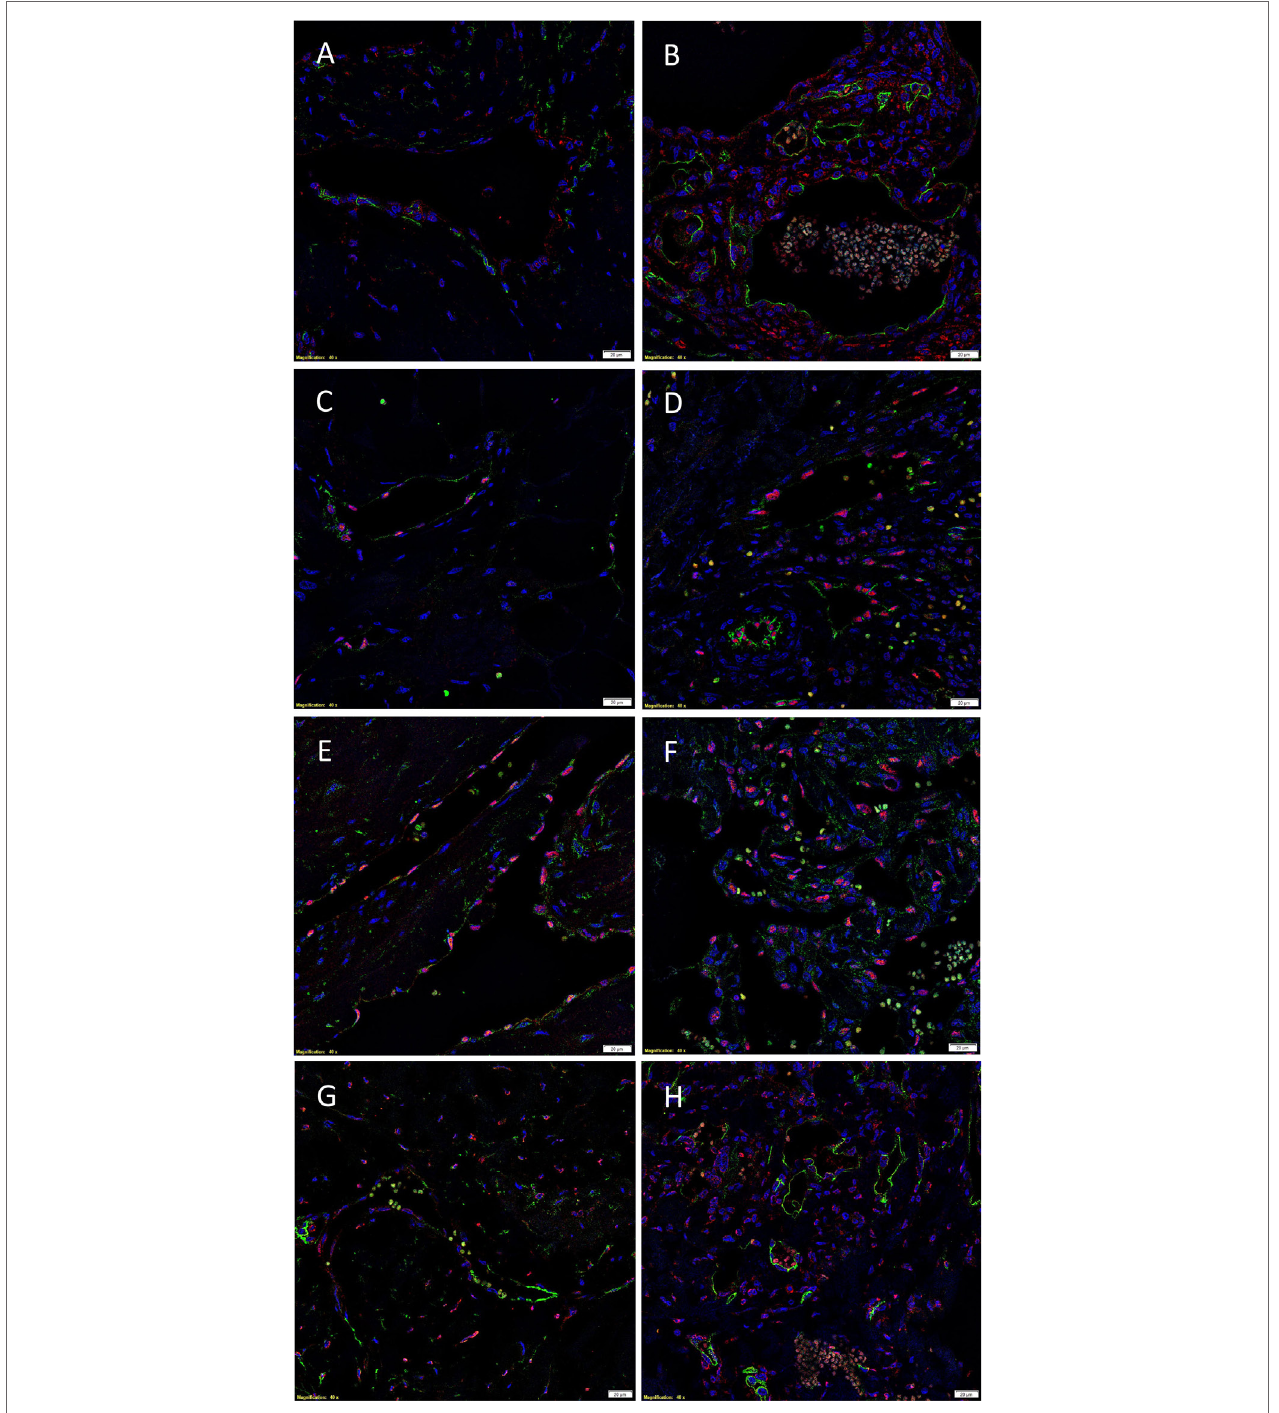
FigUre 4 | representative iF ihc-stained sections of iM (a,c,e,g) and sc (B,D,F,h) VM demonstrating the expression of Prr in iM [(a), red] and sc [(B), red] lesions . Endothelial cells were identified by the endothelial marker CD34 [ (a,B) , green]. ACE was also expressed on the endothelium of IM [ (c) , green] and SC [ (D) , green] lesions. ATIIR1 was expressed on the endothelium of both IM [ (e) , green] and SC [ (F) , green] VM. The endothelial cells were identified using the endothelial marker ERG [ (c–F) , red]. ATIIR2 also demonstrated positive staining in IM [ (g) , red] and SC [ (h) , red] VM. The endothelial cells were identified using CD34 [ (g,h) , green]. Cell nuclei were counterstained with 4 ′ ,6-diamidino-2-phenylindole (blue). Scale bars: 20 μ m.